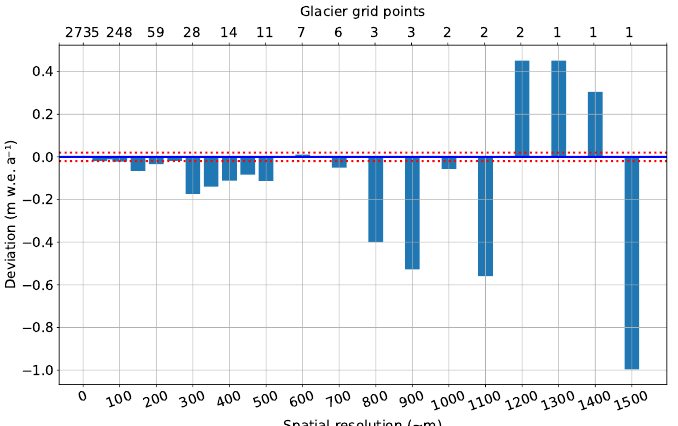
Figure 5. Deviations of the mean annual glacier-wide climatic mass balance of the Halji glacier to the reference 30m simulation for the mass-balance years (MB-years) 1982 to 2019 for different spatial resolutions ranging from 60 to 1500m. Corresponding glacier grid points are on the second x-axis. The red dotted lines showing the selected threshold for deviations in a tolerable range (±0.02mw.e.a −1